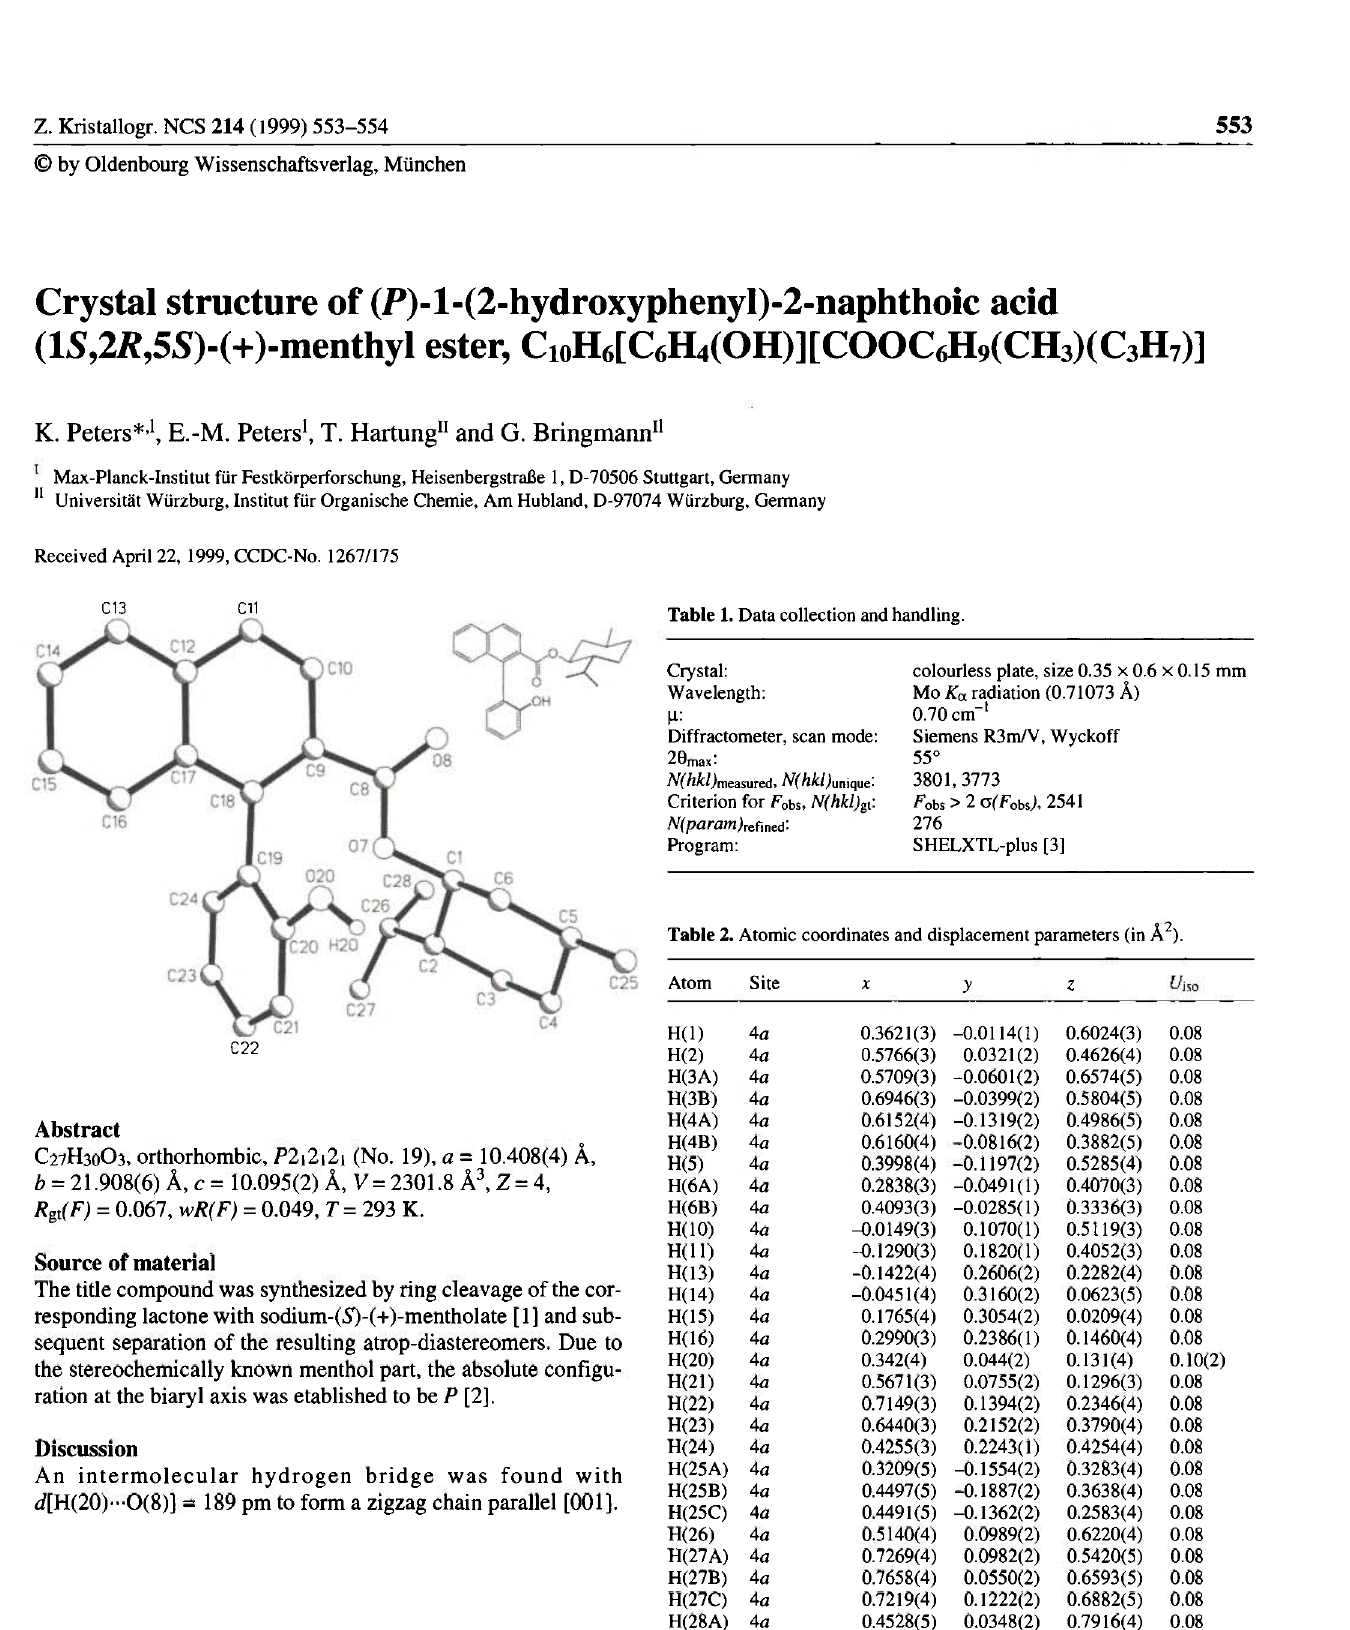
Table 2. Atomic coordinates and displacement parameters (in Ä 2